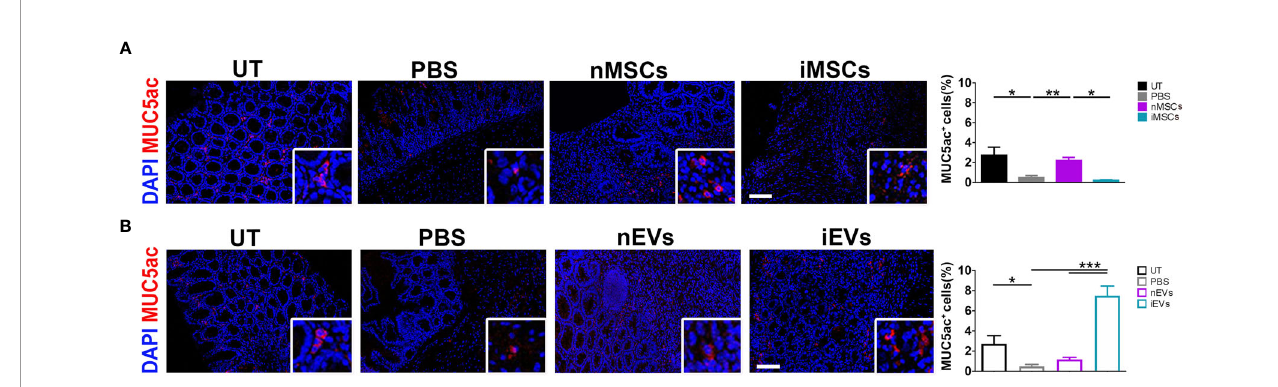
FIGURE 7 | iEVs strongly enhance Mucin 5ac in mice with colitis. (A) Quanti fi cation of MUC5ac in colon mucosa in nMSCs and iMSCs mice: IF (left), quanti fi cation (right). (B) Quanti fi cation of mucin 5ac in colon mucosa in nEVs and iEVs mice: IF (left), quanti fi cation (right). Results are mean ± standard error (n = 5). *P < 0.05, **P < 0.01, ***P